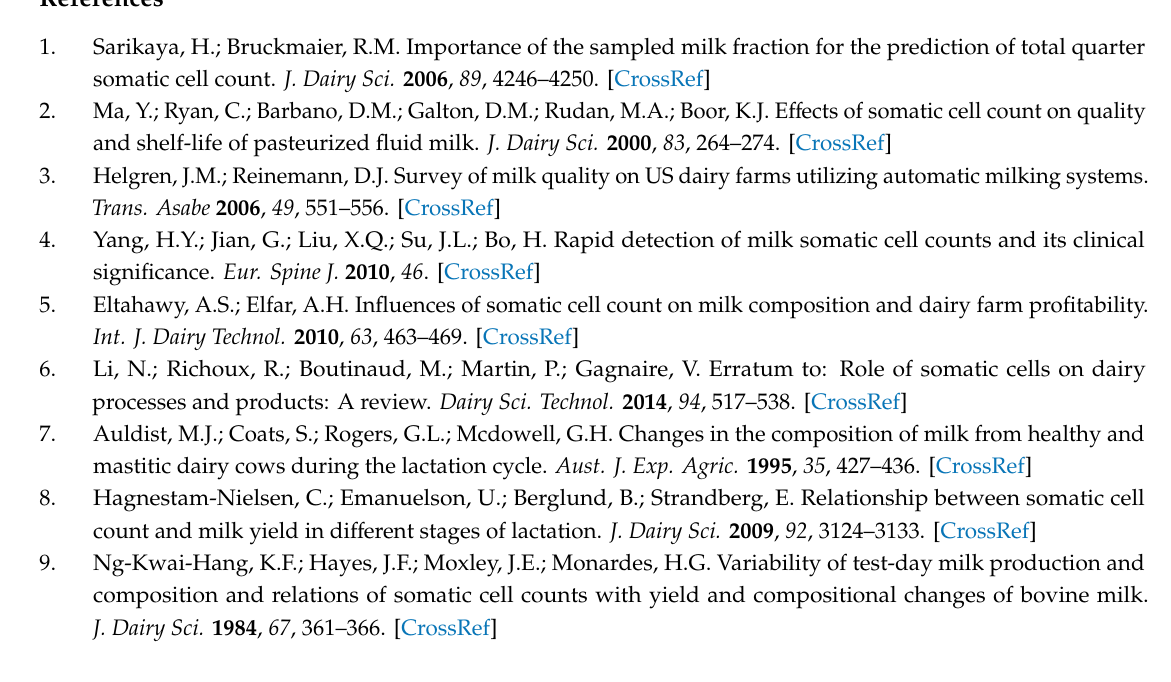
Figure S1: PCA analysis of the mRNA of genes. Figure S2: Expression level of ten di ff erentially expressed genes detected by qRT-PCR using RPS9 as reference gene and